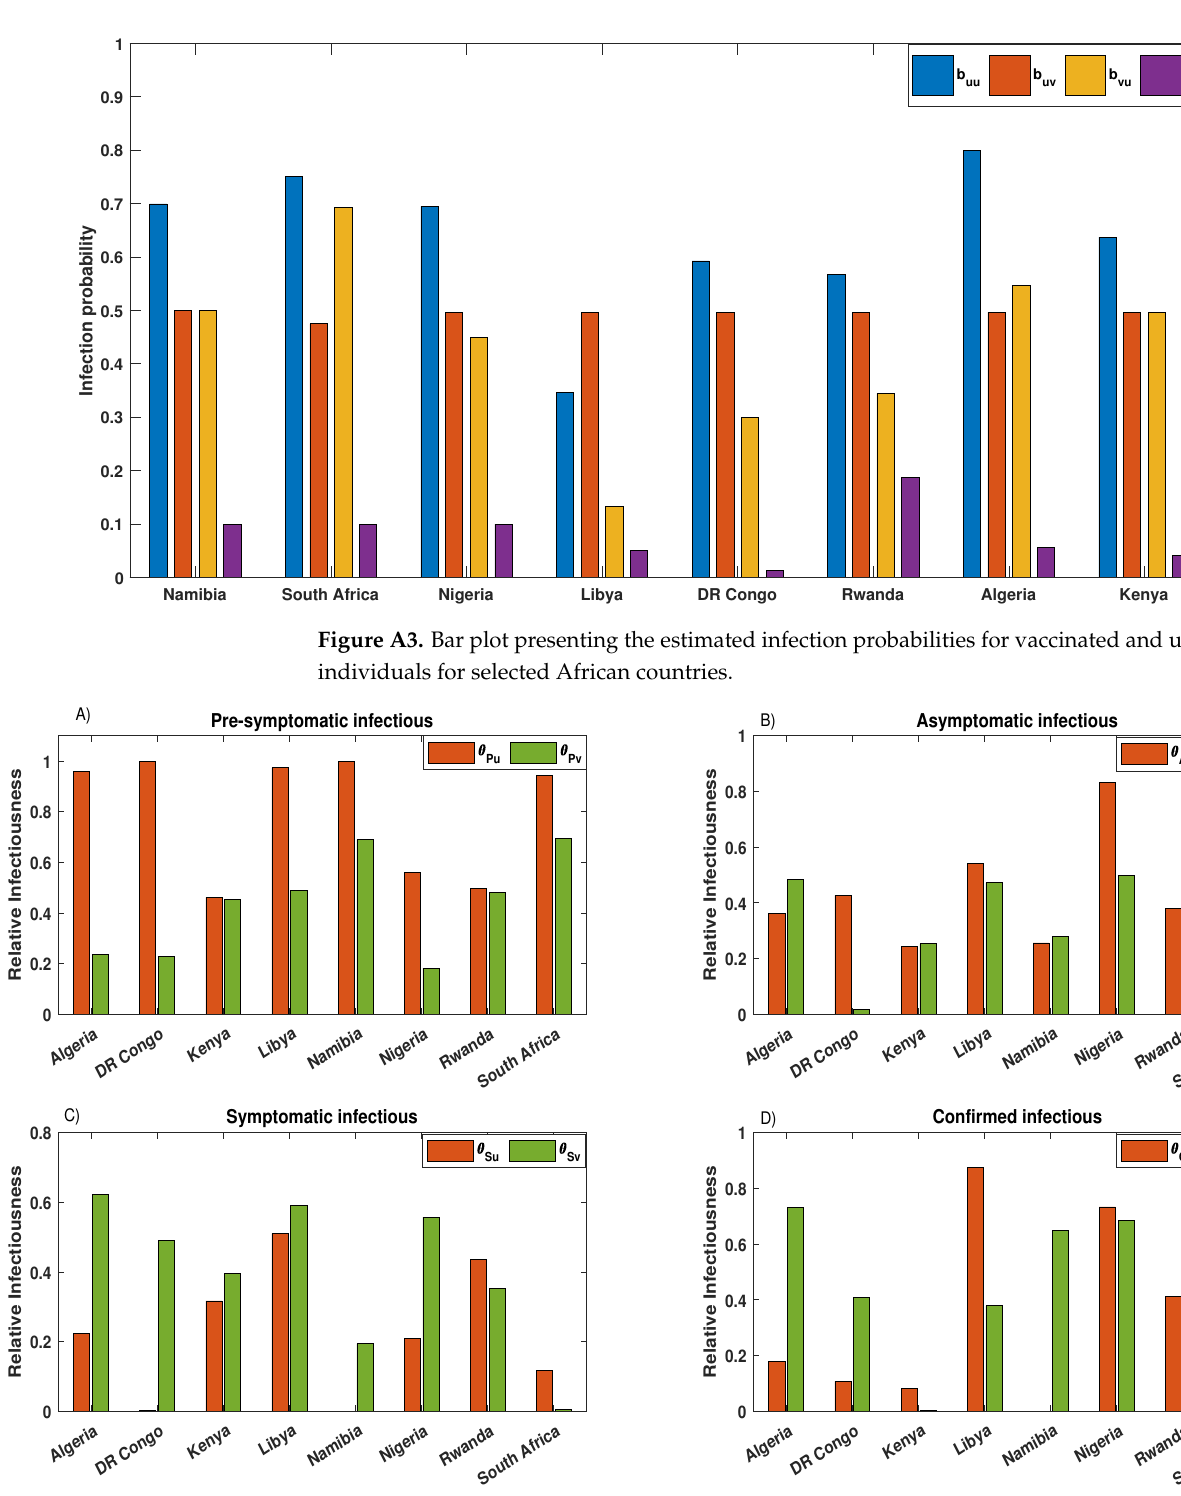
Figure A4. Plots presenting the estimated relative infectiousness for vaccinated and unvaccinated individuals for selected African countries. ( A ) Pre-symptomatic infectious, ( B ) Asymptomatic infectious, ( C ) Symptomatic infectious, and ( D ) Confirmed